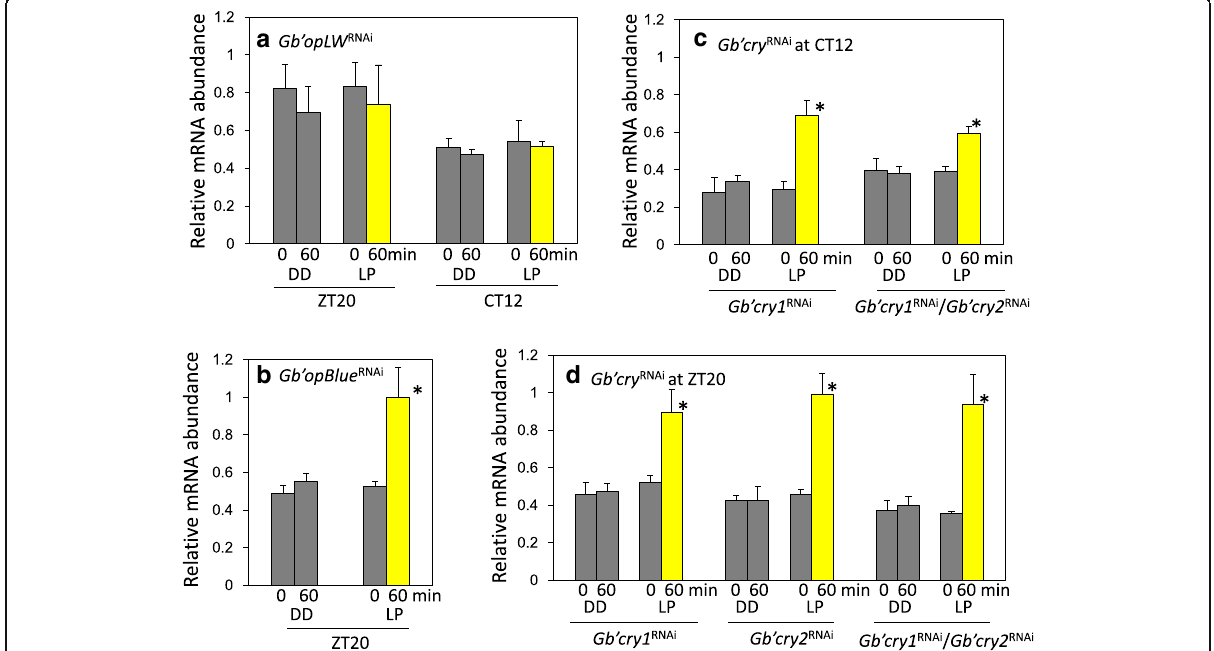
Fig. 4 Effects of RNAi of Gb ’ opLW ( a ), Gb ’ opBlue ( b ), and Gb ’ cry genes ( c , d ) on light induced Gb ’ c-fosB mRNA expression in the cricket Gryllus bimaculatus . Gray and yellow columns indicate samples kept in darkness or exposed to light for 60 min, respectively. DD, kept in darkness; LP, exposed to light. Bars indicate SEM. N = 3 or 4. a Gb ’ opLW RNAi suppressed light-induced upregulation of Gb ’ c-fosB . b-d RNAi of Gb ’ opBlue or Gb ’ cry genes had no effects on the light-induced upregulation of Gb ’ c-fosB at ZT20 and CT12. * P < 0.05, t-test